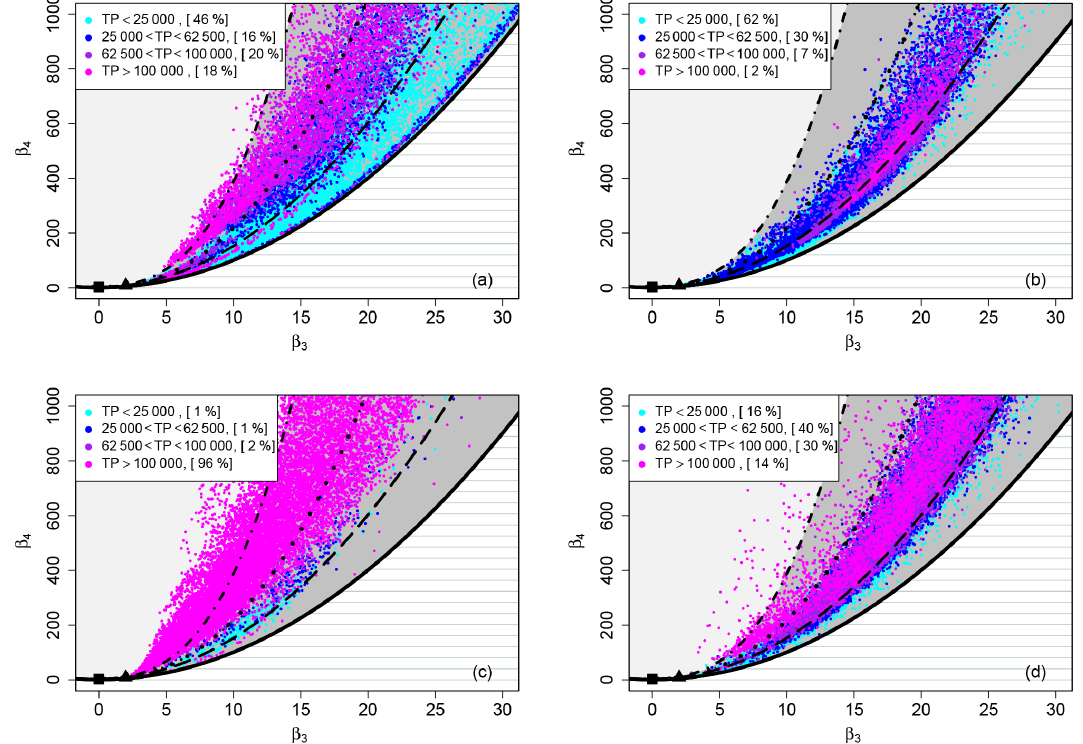
Figure 3. Location of the sample couples ( β 3 , β 4 ) from SC1 (a) , SC2 (b) , MI3 (c) , and MI8 (d) datasets in the skewness–kurtosis plane with theoretical distribution reference domains. Cyan dots represent PNSDs with TP < 25000, blue dots 25000 < TP < 62500, purple dots 62500 < TP < 100000 and magenta dots TP > 100000. The dotted-dashed line is the lognormal distribution, the dotted line is the Weibull distribution and the dashed line is the gamma